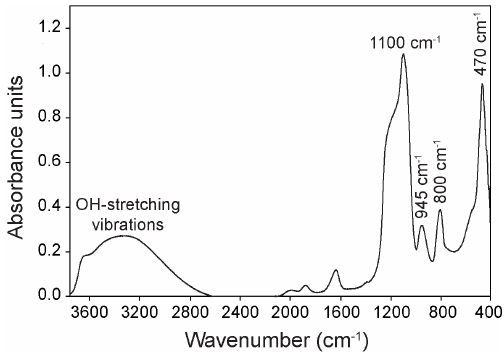
Fig. 4. FTIR spectrum of biogenic silica (BSi) from a sediment sam- ple of Lake El’gygytgyn (core Lz1024, sample depth: 1.5m, sample age: 22ka) that was purified according to Chapligin et al. (2012). The spectrum shows distinct absorption bands at around 1100, 945, 800 and 471cm − 1 , which are associated with asymmetric Si-O-Si stretching, Si-OH molecular, symmetric Si-O-Si stretching, and Si- O-Si bending vibrations,